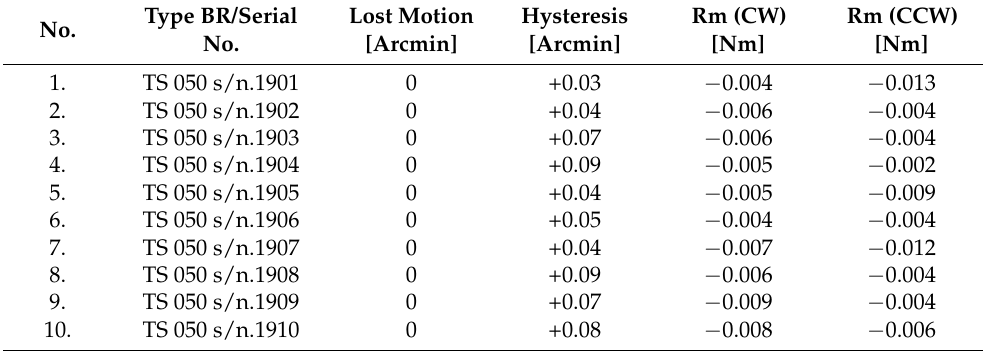
Table 6. Difference of measured parameters LR 050 before and after the trial run (configuration